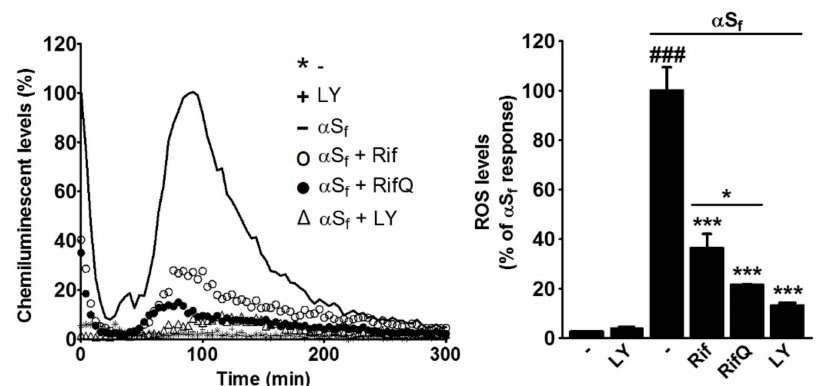
Figure 6. Rif and RifQ prevent reactive oxygen species production in microglial cells activated by α S f. Left panel shows a representative kinetic profile of superoxide formation as a percentage of the maximal response elicited by α S f . The light intensity was monitored continuously for 300 min. Experimental values in the right panel represent the means of the area under the curve in percentage of the maximal response elicited by α S f . Data are expressed as the mean ± SEM of four independent experiments performed in triplicate. Note: ### p < 0.001 vs. controls, * p < 0.05 Rif vs. RifQ, *** p < 0.001 vs. α S f